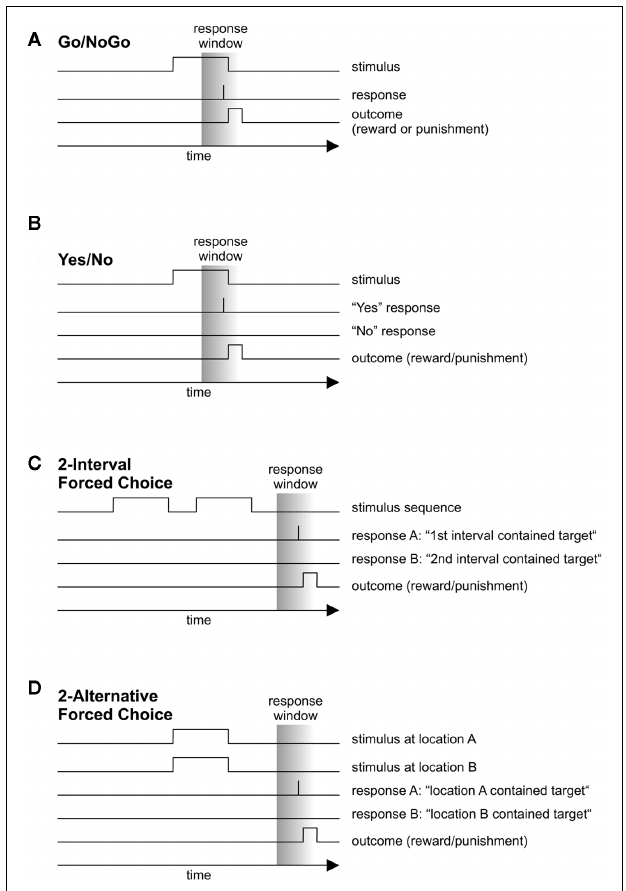
FIGURE 2 | Sequence of events in four tasks commonly employed in animal psychophysics. (A) Go–NoGo task. (B) Yes/no task. (C) Two-interval forced choice task. (D) Spatial two-alternative forced choice task.